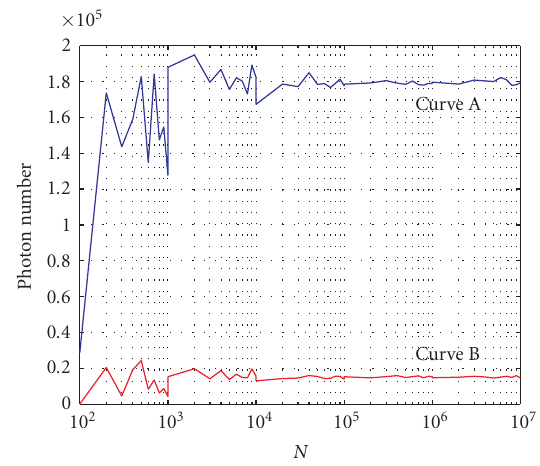
Figure 3: TBRS simulation results with di ff erent table sizes. N de- notes the table size. Curve A and Curve B denote the maximized and minimized numbers of photons received among the 24 sensors in the simulations.